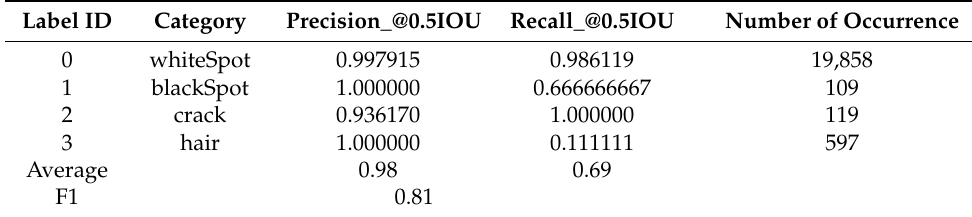
Table 4. Confusion matrix for the developed ML model based on Faster R-CNN Inception v2 COCO in detection of medical MEMS